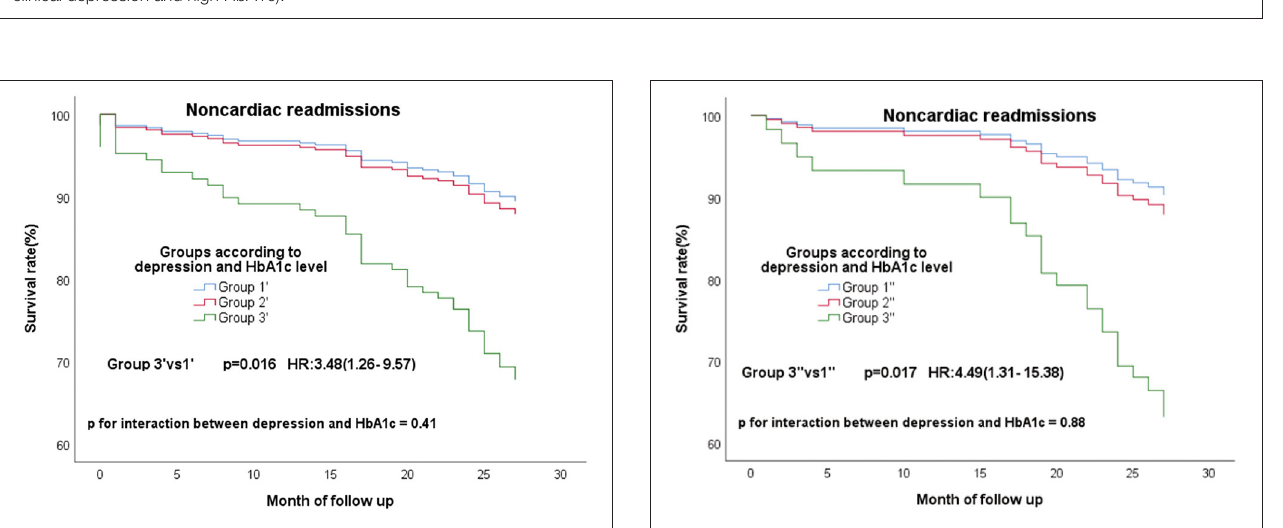
FIGURE 3 | Cox regression curves for MACE (A) and composite endpoint (B) by the four groups of CAD patients without diabetes. (Group1’: patients without clinical depression and low HbA1c; Group2’: patients with clinical depression and low HbA1c, patients without clinical depression and high HbA1c; Group3’: patients with clinical depression and high HbA1c).